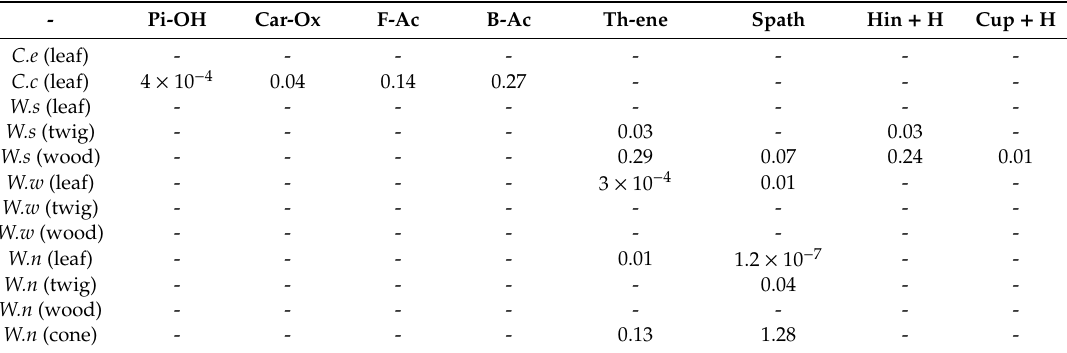
Table 2. Yields of specific terpenes and pisiferol across the species and plant parts in percent ( g / g ). C.e = Callitris endlicheri , C.c = C. columellaris , W.s = Widdringtonia schwartzii , W.w = W. wallichii , W.n